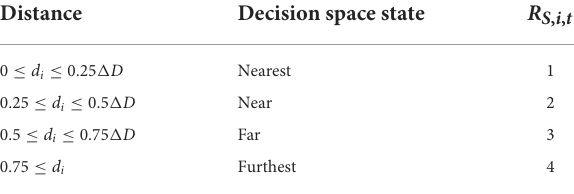
TABLE 3 Relationship between particle action and parameter